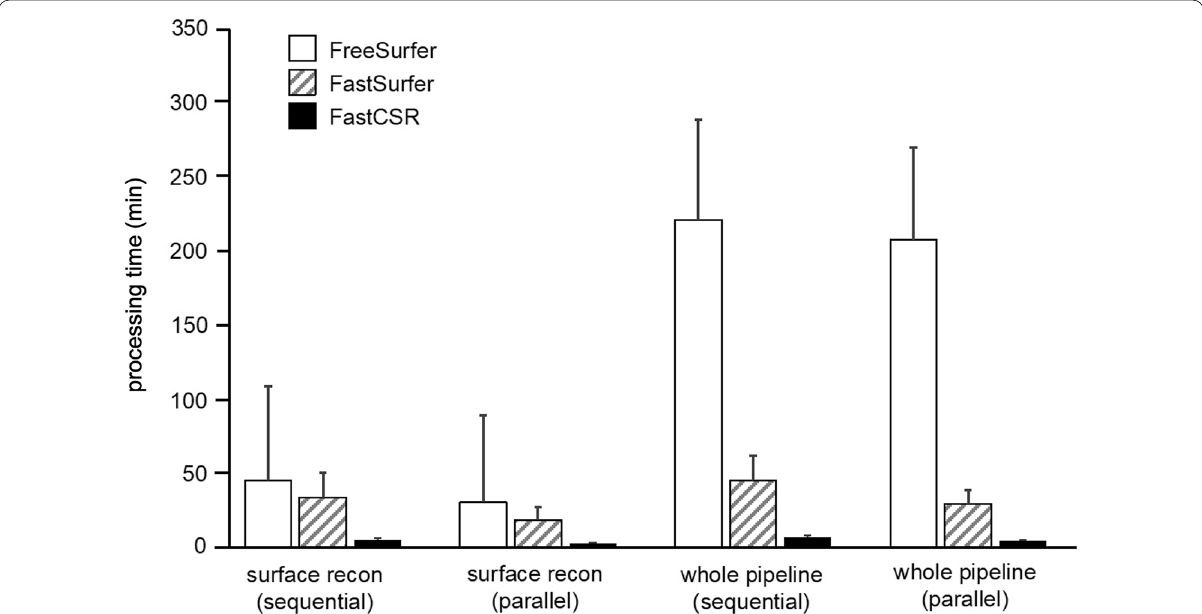
Fig. 2 Processing time of FastCSR, FreeSurfer and FastSurfer. The bar graphs illustrate differences in the average processing time for the validation dataset using FreeSurfer, FastSurfer and FastCSR. We compared the processing times for the surface reconstruction step alone (surface recon) and the whole pipeline including all necessary preprocessing steps for surface reconstruction using either sequential or parallel processing, the latter of which processes both hemispheres simultaneously. Among the three methods, FastCSR achieved the highest computational efficiency for the surface reconstruction step (5.22 0.92 min and 2.61 0.46 min for sequential and parallel processing, respectively), as well as for the whole ± ± pipeline (7.05 0.92 min and 4.44 0.46 min for sequential and parallel processing, respectively). Error bars indicate standard ± ±